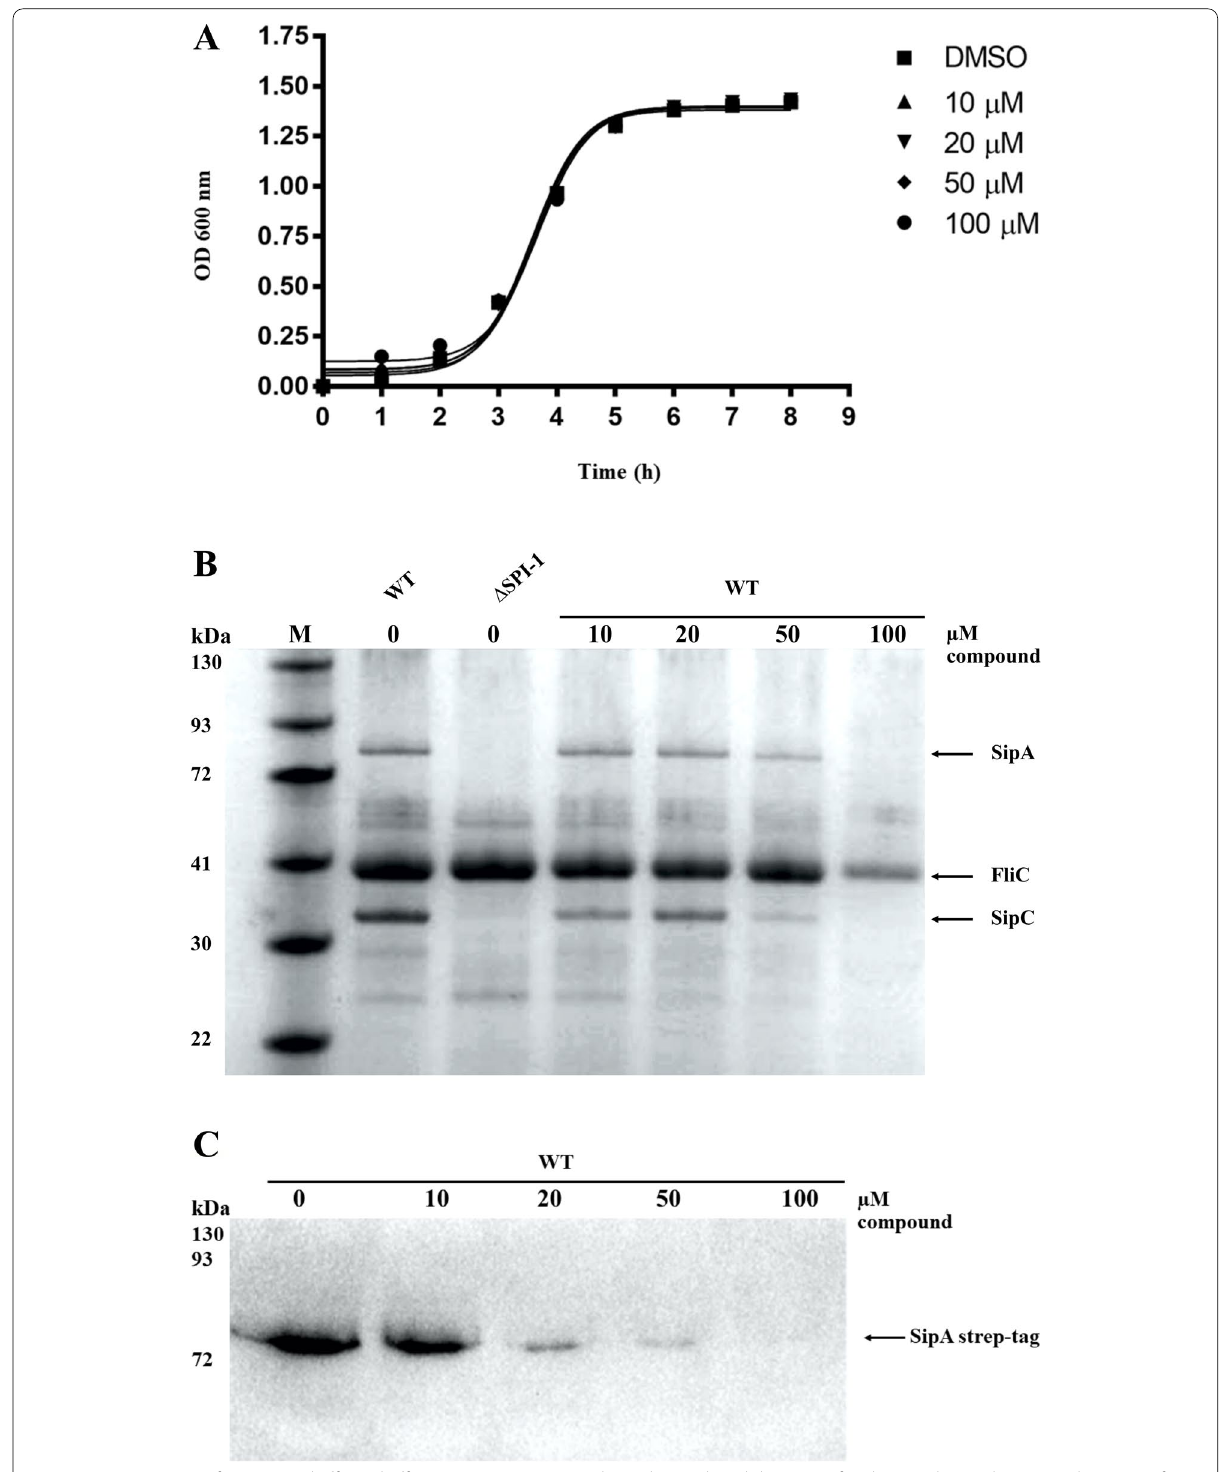
Fig. 2 Concentration of compound affected effector protein secretion through T3SS but did not interfere bacterial growth. A Growth curves of S. Typhimurium at various concentration of compound. The control was bacterial culture with DMSO. The results from SDS-PAGE ( B ) and Western blotting ( C ) indicated that at 100 μM of compound inhibited T3S. The SPI-1 deficiency strain ( invC::kan R ) was used as